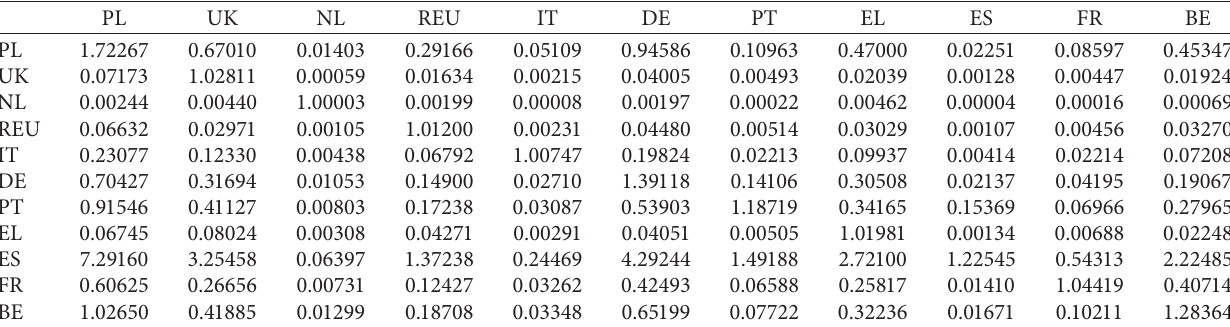
Table 11: Triangulated matrix 2007.